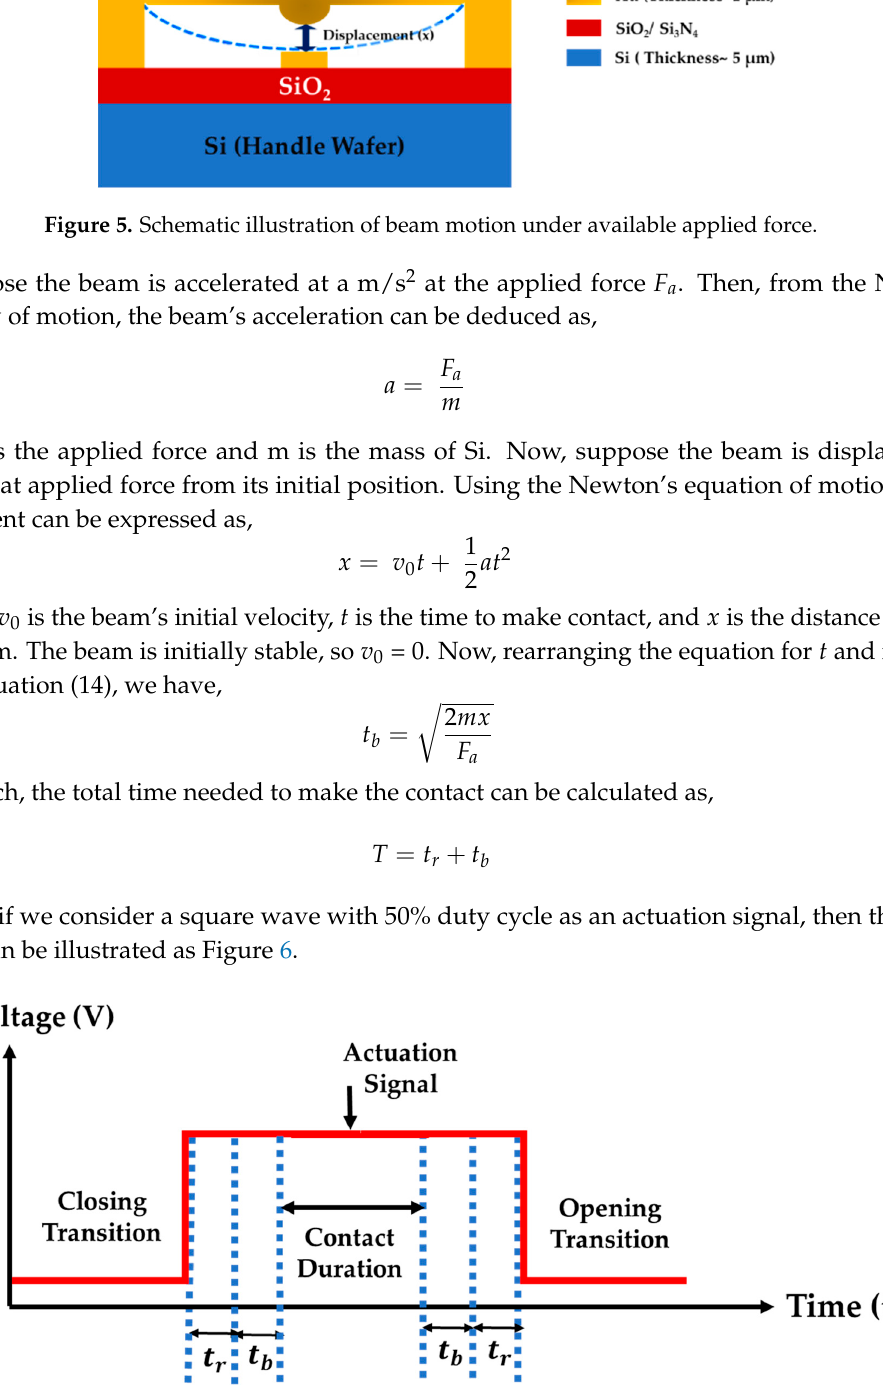
Figure 6. Typical timing diagram associated with microcontact actuation signal. The red pulse represents the time elapsed by an actuation signal, the first dotted blue line represents the time delay associated with the piezoelectric actuator ( t r ), and the second dotted blue line represents mechanical contact closure time associated with a Si beam ( t b